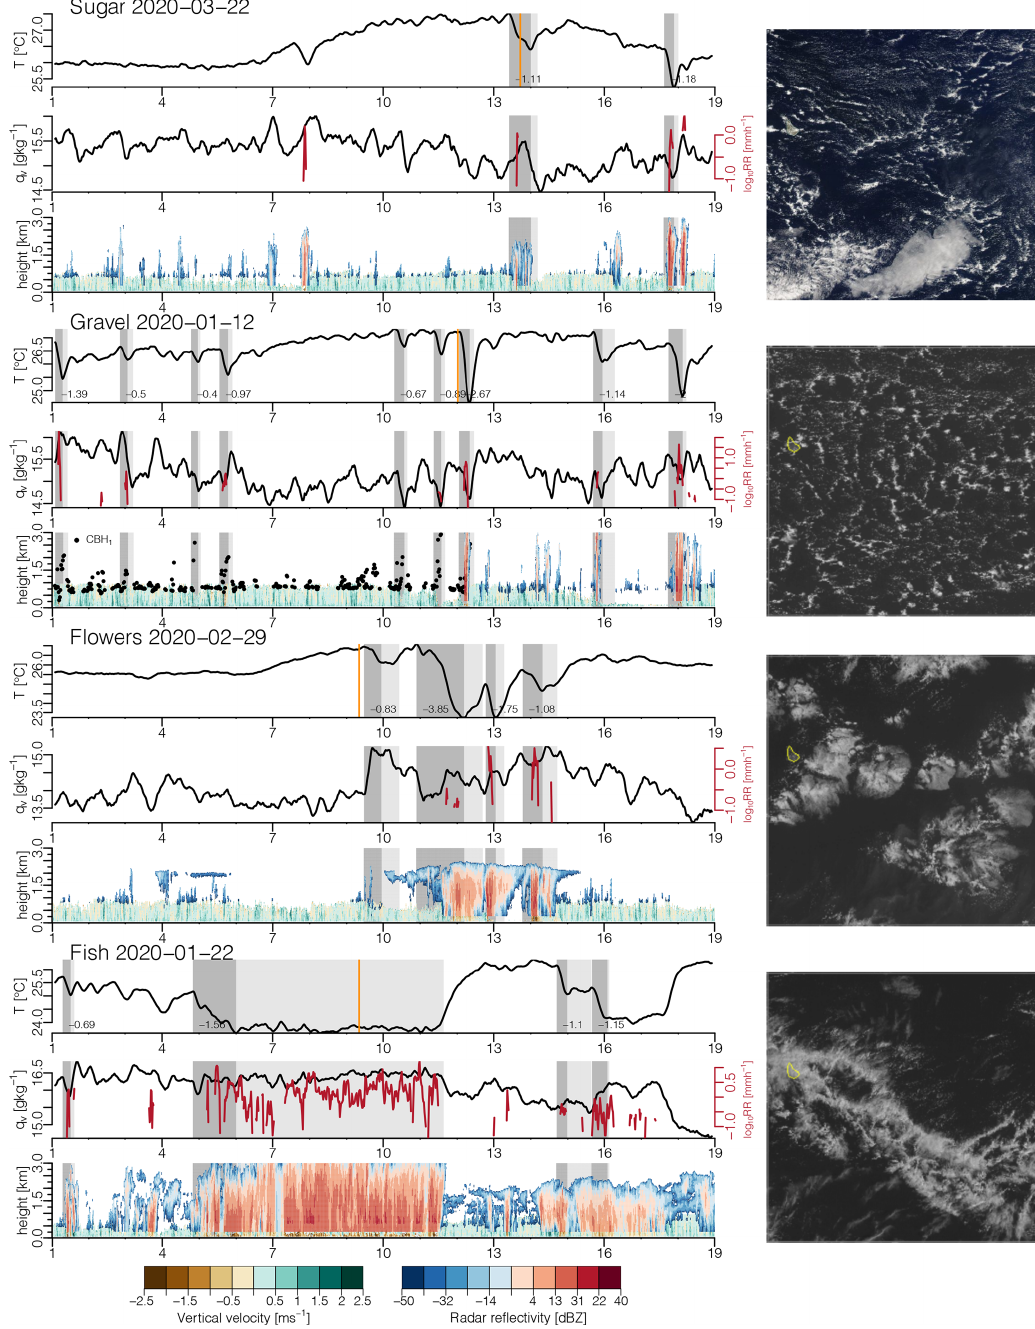
Figure 2. BCO time series and satellite images for 18h of 4 cold-pool days representative of the four patterns. Shown are time series of filtered surface temperature and specific humidity, MRR rain rate, and time–height plots of Doppler lidar vertical velocity and radar reflectivity. On the Gravel day the radar did not work prior to 12:00LT, and the first ceilometer cloud base (CBH 1 ) is shown instead. The x axis shows local time and the detected cold-pool fronts and wakes are indicated in grey and light grey, with (cid:49)T indicated at the bottom. Visible satellite images from 10–15 ◦ N, 60–55 ◦ W are from MODIS Aqua (Sugar day) and GOES-16 ABI (other days), with the respective recording times indicated by the orange lines in the temperature panels. The BCO is located near the easternmost tip of Barbados (outlined in